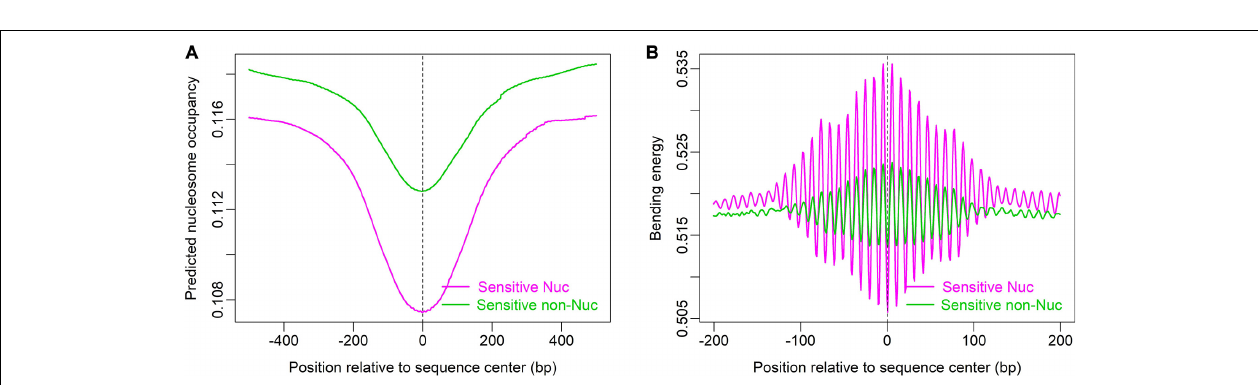
FIGURE 6 | MNase-sensitive nucleosomes have lower predicted nucleosome occupancy than MNase-sensitive non-histone molecules (A) but are rotationally more locked than the latter (B) . Genomic positions of MNase-sensitive particles were provided by the author of the literature (Chereji et al., 2017).